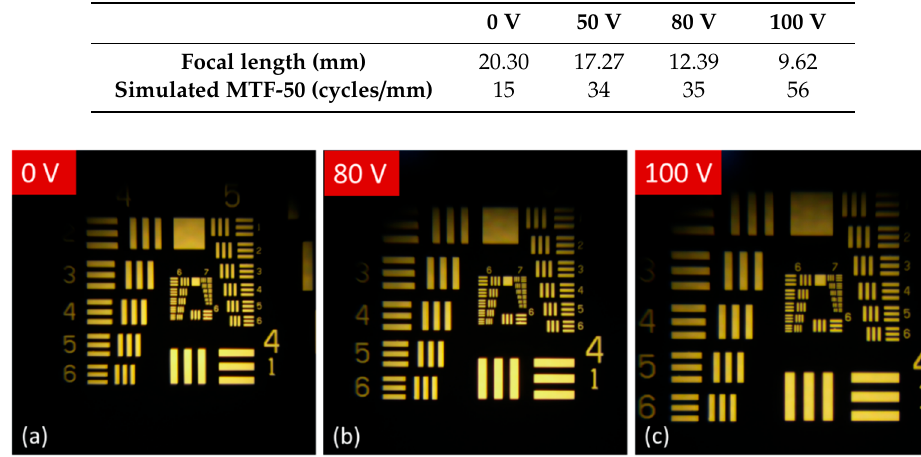
Table 2. Measured focal length of the lens and MTF-50 values simulated in ZEMAX from Shack–Hartmann wavefront sensor data reported in Figure 6 and Table 1.